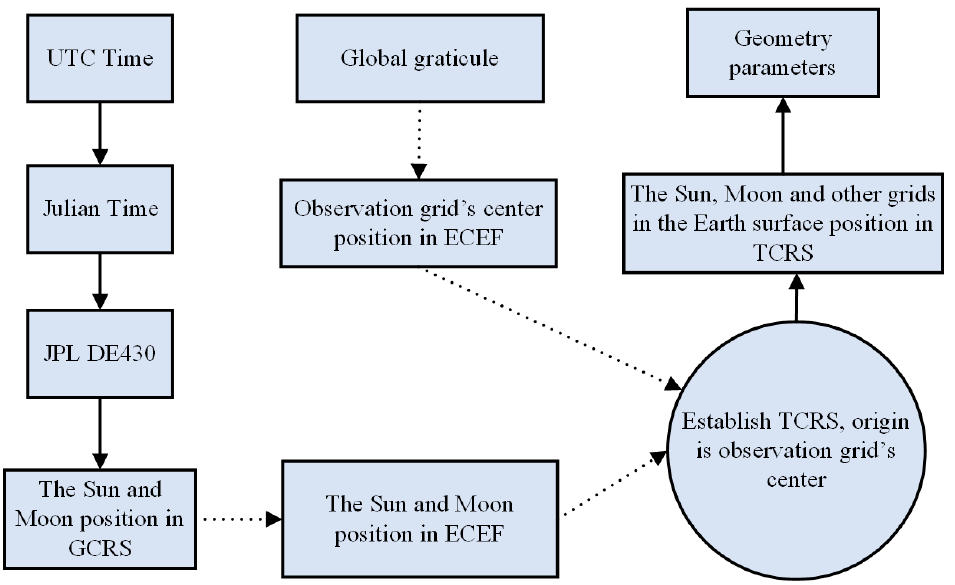
Figure 3. Transformation of reference systems to obtain geometrical parameters.